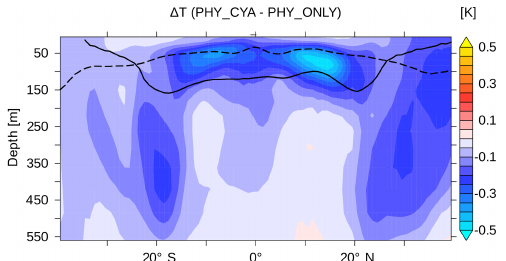
Figure 4. Difference in the climatological global zonal mean temperature (K) in the upper 550m between PHY_CYA and PHY_ONLY. The dashed black line shows the global zonal mean MLD and the solid black line the global zonal mean thermocline depth (defined as the depth of the 20 ◦ C isotherm) in